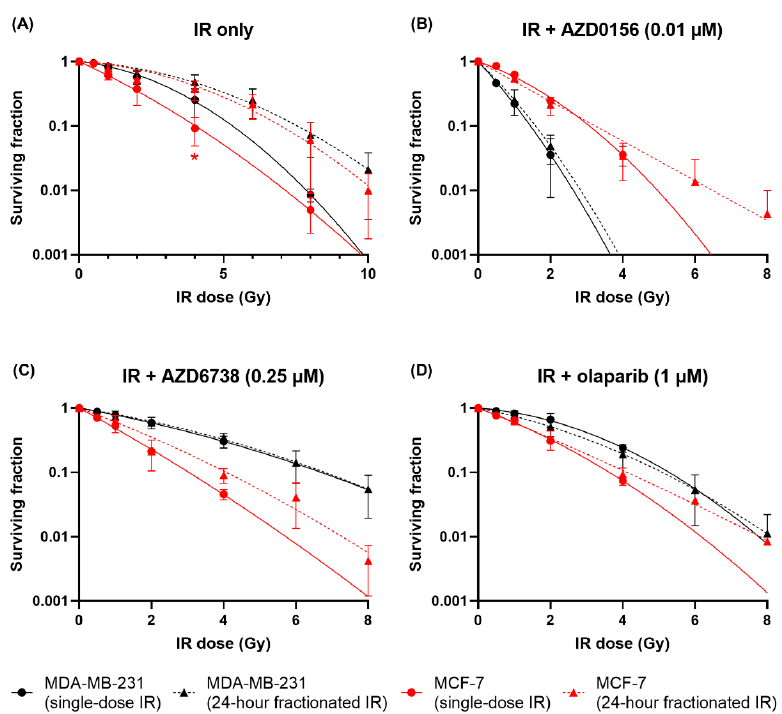
Figure 7. DDR inhibitors reduce the survival benefit of IR dose fractionation. The survival curves of MDA-MB-231 and MCF-7 cells treated with single-dose or 24-h fractionated IR with or without DDR inhibition were compared. Data are shown as mean ± SD of three independent experiments performed in duplicate or triplicate wells. * p < 0.05 for single-dose IR vs. 24-h fractionated IR. Table 2. Mean inactivation dose ( 𝐷(cid:3365) ) of single-dose and 24-h fractionated IR with and without DDR inhibition and the sensitizer enhancement ratio (SER) of each DDR inhibitor in MDA-MB-231 and MCF-7 cells. 𝐷(cid:3365) values were estimated by calculating the area under the survival curves in Figures 5 and 6. SER values were calculated as the 𝐷(cid:3365) for the IR-only groups divided by the 𝐷(cid:3365) for the IR and drug combination groups. Data are shown as mean ± SD of three independent experiments performed in duplicate or triplicate wells. Treatment